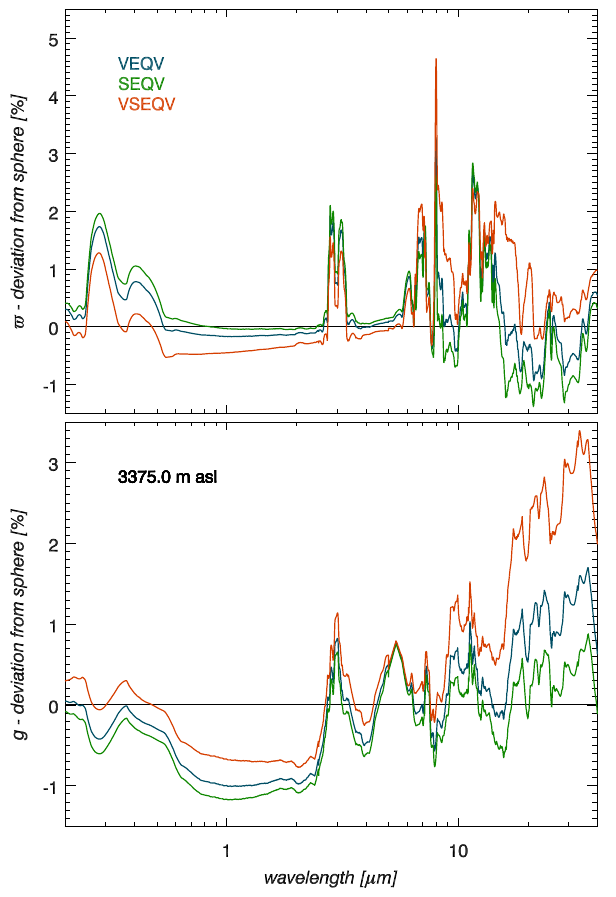
Fig. 10. Simulated percental deviations in the single scattering albedo (top) and asymmetry parameter (bottom) between prolate spheroidal and spherical model particles as a function of wavelength applying the measured AR distributions (Fig. 1). The full-spectral computations were performed assuming the size equivalence cases of VEQV (blue), SEQV (green) as well as VSEQV (red) and are representative for an altitude of 3375m a.s.l. at the centre of the mineral dust plume as observed on 19 May 2006 over OZT site about noon.